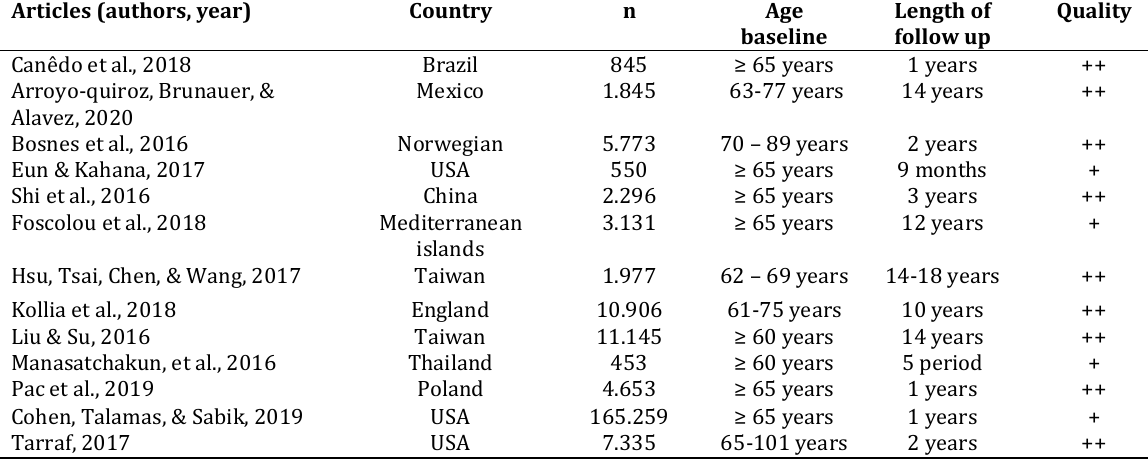
Table 1. Overview of included